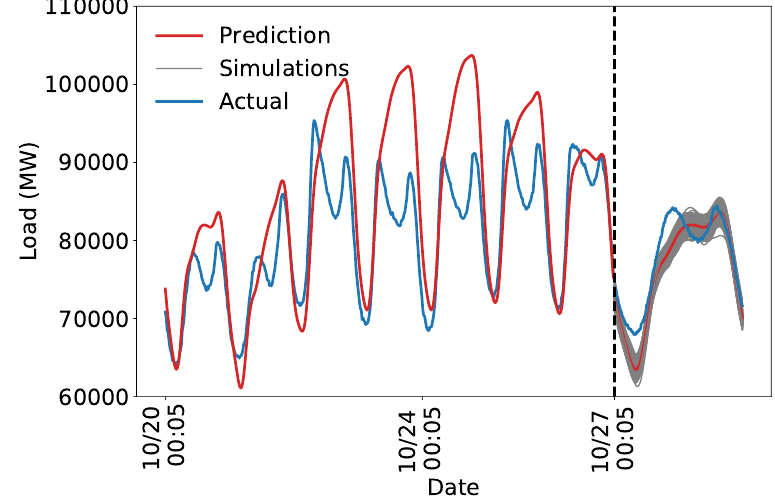
Figure 8. Backcasted and forecasted load using a composite kernel with daily and weekly periodicity. Dashed vertical line indicates the transition from training data to test